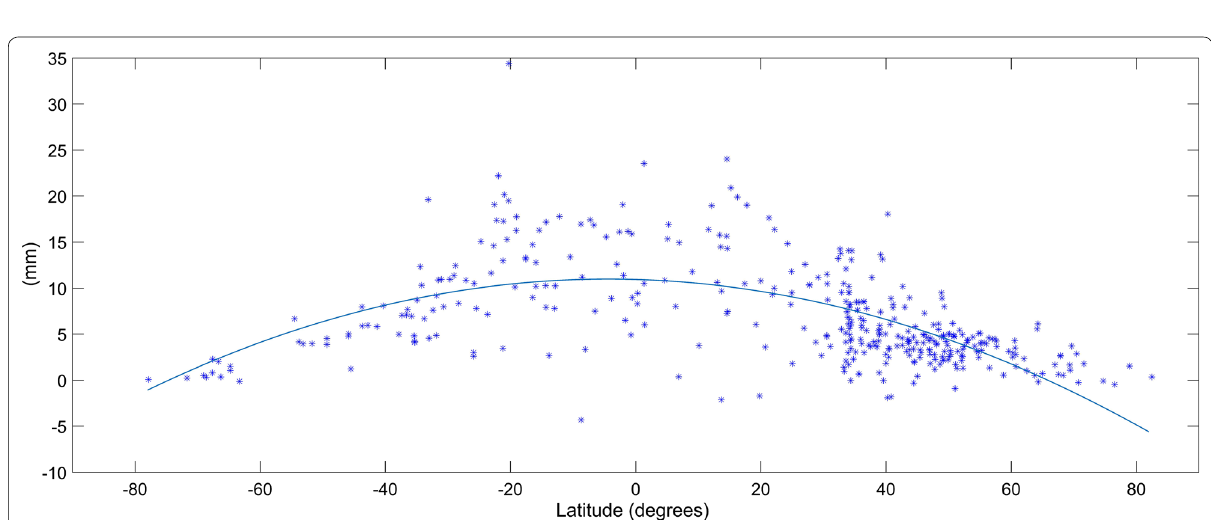
Fig. 5 Zenith wet delay bias (UNB-VMF1 VMF1) versus latitude for the GPS DDA stations ( y = 0.002 x 2 − 0.019 x + 10.998 ). The discrepancy at − IQQE station is at 34